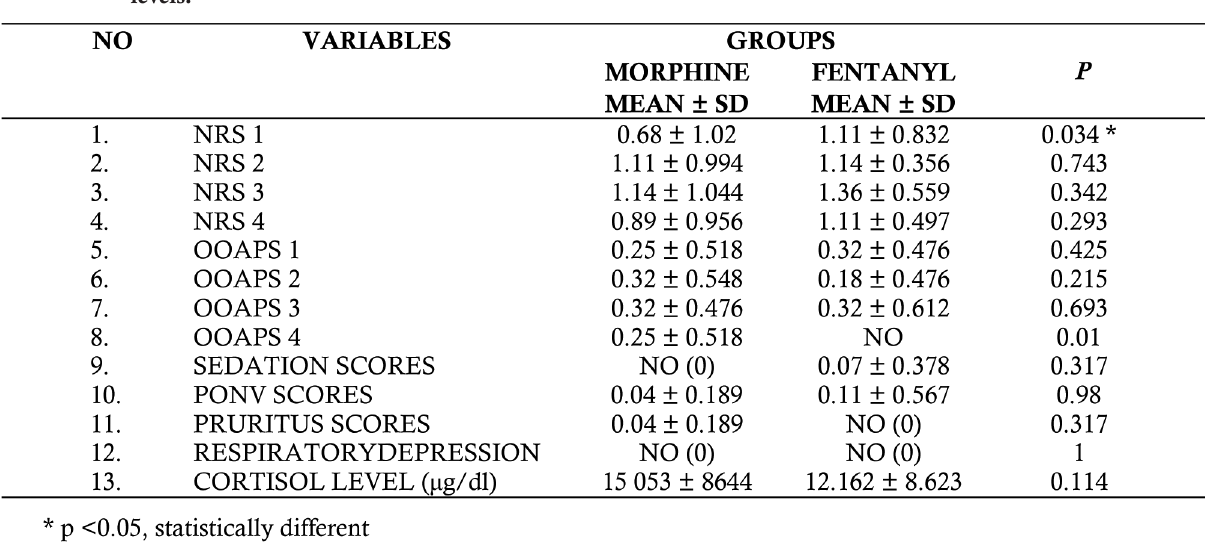
Table 2. Numeric Rating Scale (NRS) Score 1-4, Observer’s Objective Assessment of Pain Scores (OOAPS) 1-4, sedation score, Postoperative Nausea and Vomiting (PONV) scores, pruritus score, respiratory depression and cortisol